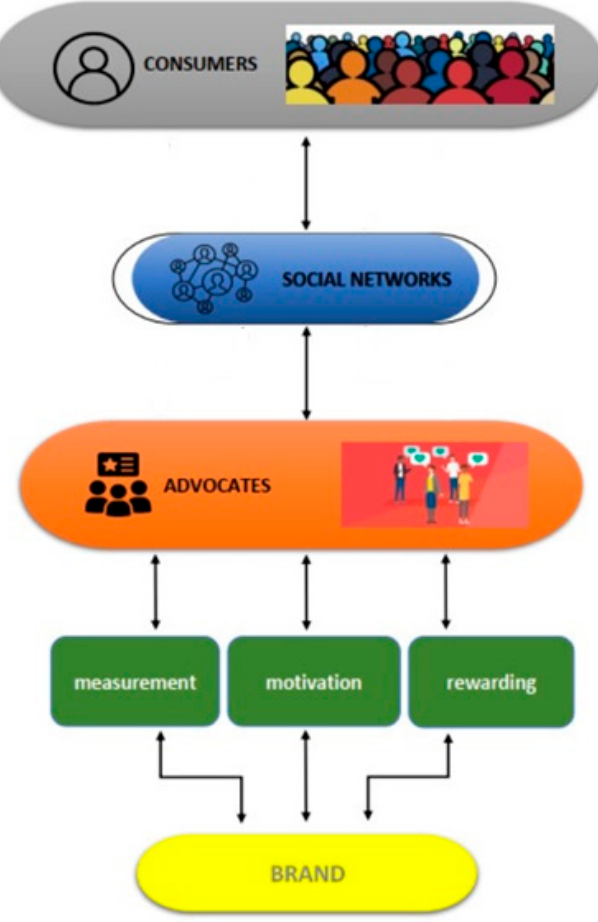
Figure 2. The architecture of the ADVO system .